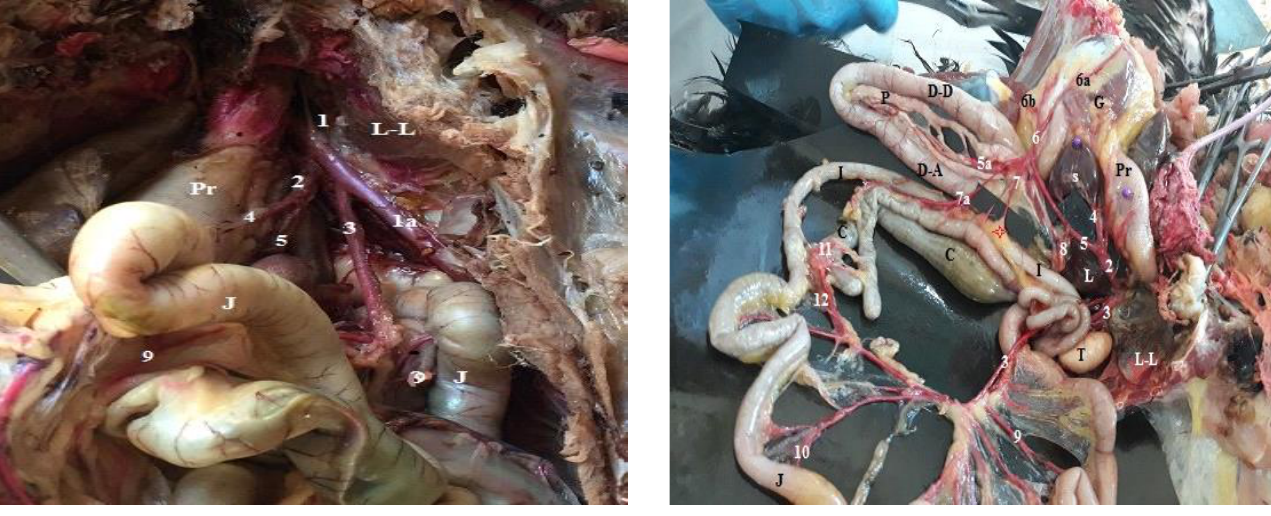
Figure 2. Photograph illustrates arterial blood supply of small intestine, 2: Celiac, 3:Cranial mesenteric a. ,4: left ramus, 5:right ramus am, 5a.:pancreatico-duodenal a. , 6a, 6b :right and left gastro duodenal a.,7:7a: ileocecal a, 8,9 : jejunal a.,10:marginaintestinal artery 11:ilial a.: s: spleen ,G:Gizzard ,Pr :proventiculus, D: duodenum (D-D&D-A; descending& ascending duodenum), J : Jejunum, I-ileum, C:cecum. ,L-L :left lung , T:testis ,L: liver, red stare: ileocecal ligament